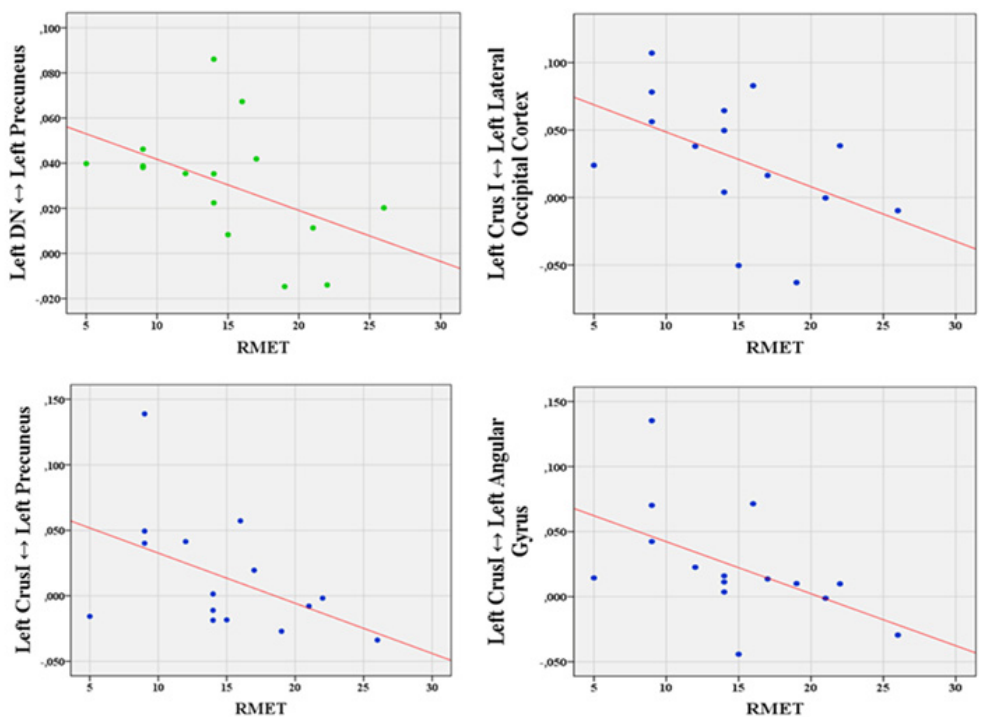
Figure 5. Scatterplots of correlations. Data scatterplots of significant correlations between RMET accuracy scores and cerebello-cerebral overconnectivity patterns. Correlations between RMET and left DN FC alterations are shown in the top panel in green; Correlations between RMET and left Crus I FC are shown in the bottom panel in blue. RMET: Reading the Mind in the eyes test [26]. DN: Dentate nucleus.